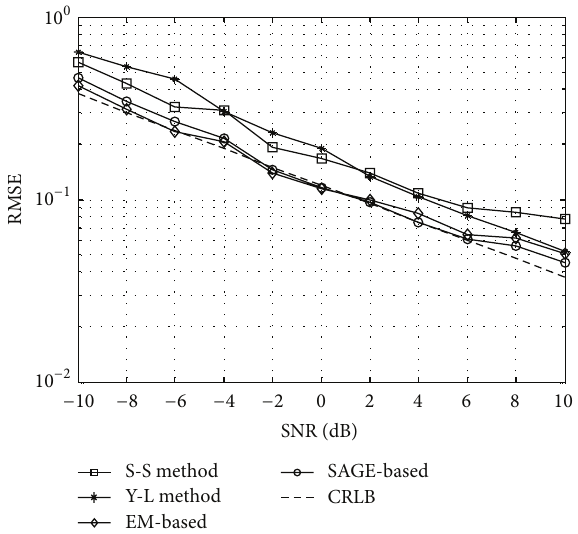
Figure 2: RMSE of coupling coefficients of different methods against SNR.